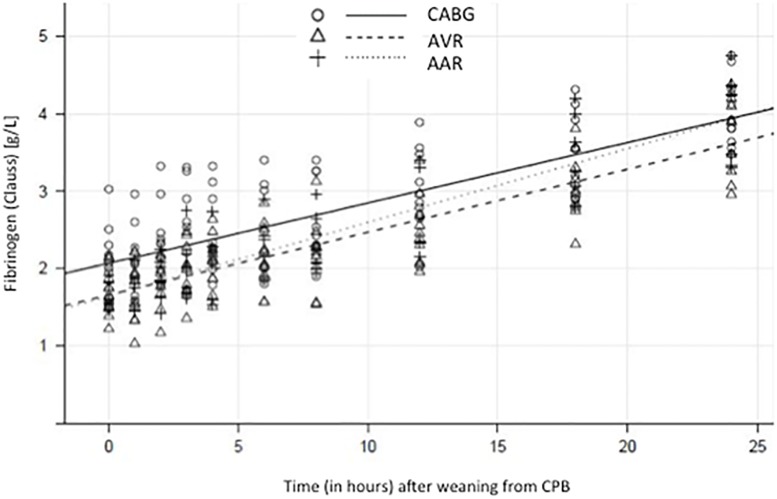
Clauss fibrinogen increase after weaning from CPB, according to surgery type.Clauss fibrinogen measurements over time, starting at the time point Protomine. The comprehensive plots show all patients, with the three types of surgery represented by different symbols. Predictions based on the fixed effects of the three respective linear mixed-effects models are superimposed.